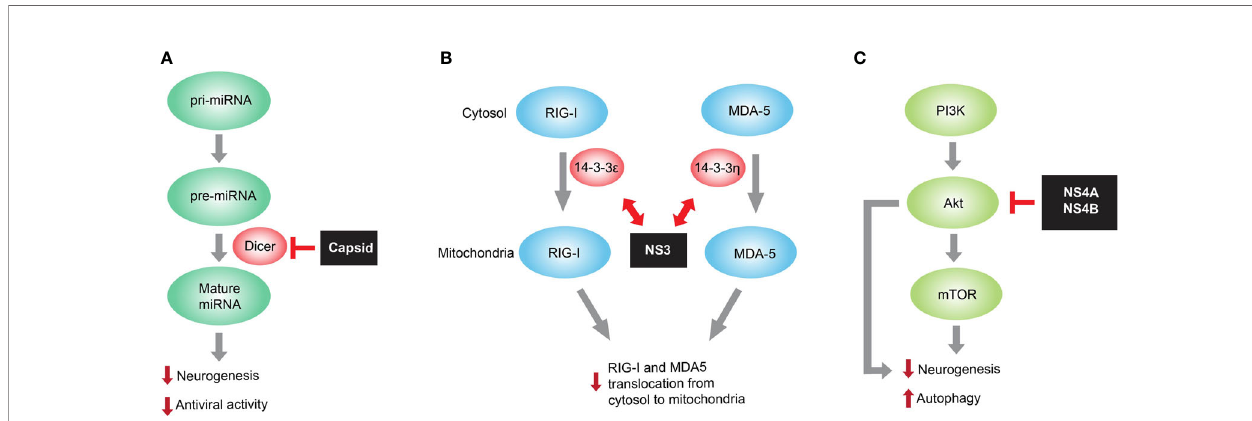
FIGURE 1 | Representative ZIKV protein mediated immune evasion for facilitating viral pathogenesis. (A) ZIKV capsid interacts with Dicer, the host endoribonuclease responsible for producing mature miRNA from pre-miRNA, and dampens global miRNA production in neural stem cells. Because miRNA is necessary for both neurogenesis and antiviral function, the capsid-mediated miRNA inhibition causes neurogenesis impairment and reduced miRNA-mediated antiviral activity in developing brain. (B) ZIKV NS3 encodes a highly conserved 14-3-3-binding motif, which enables it to interact with 14-3-3 ϵ / h required for translocation of RNA sensor RIG-I and MDA5, respectively, from cytosol to mitochondria. Such interaction prevents the translocation and thus RIG-I- and MDA-mediated antiviral interferon responses. (C) mTOR is a host factor necessary for neurogenesis and autophagy inhibition. ZIKV NS4A and NS4B inhibit Akt-mTOR signaling with unknown mechanisms and consequently impair neurogenesis and promote autophagy, thereby contributing to ZIKV pathogenesis in developing